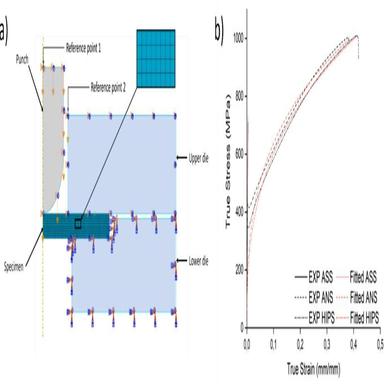
(A) Fe model of SPT (b) experimental and fitted true stress-strain of 316L steel obtained by tensile tests.